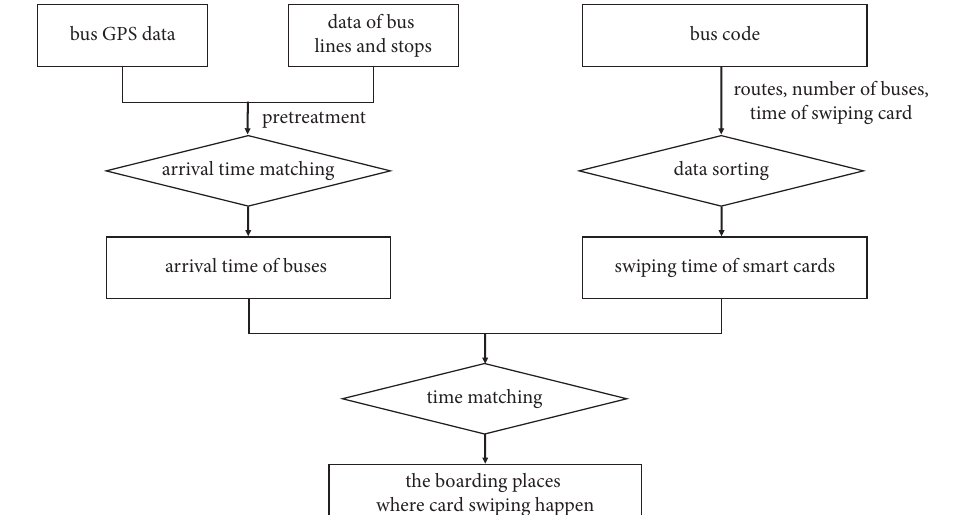
Figure 2: Matching process of passenger and station IDs.